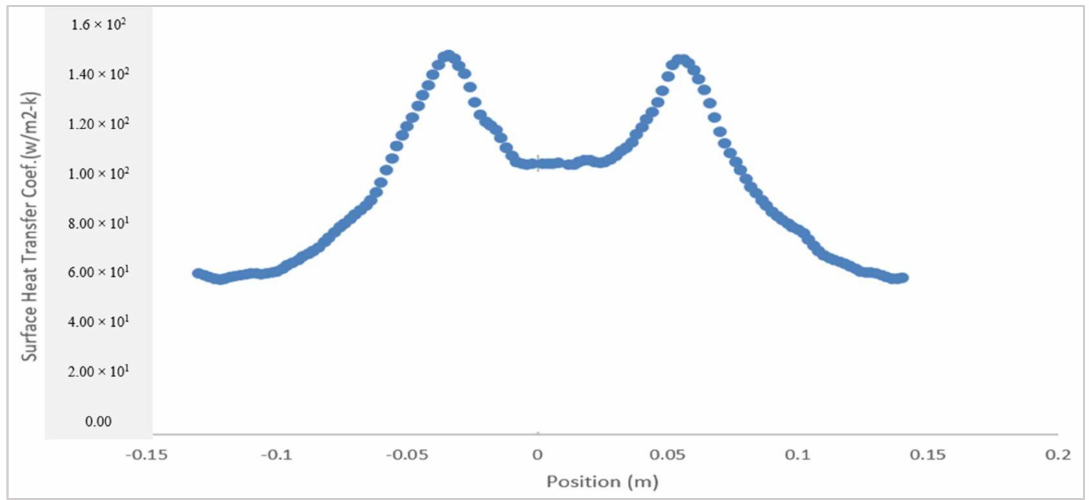
Figure 10. Heat transfer coefficient in the axial direction at Model 1.